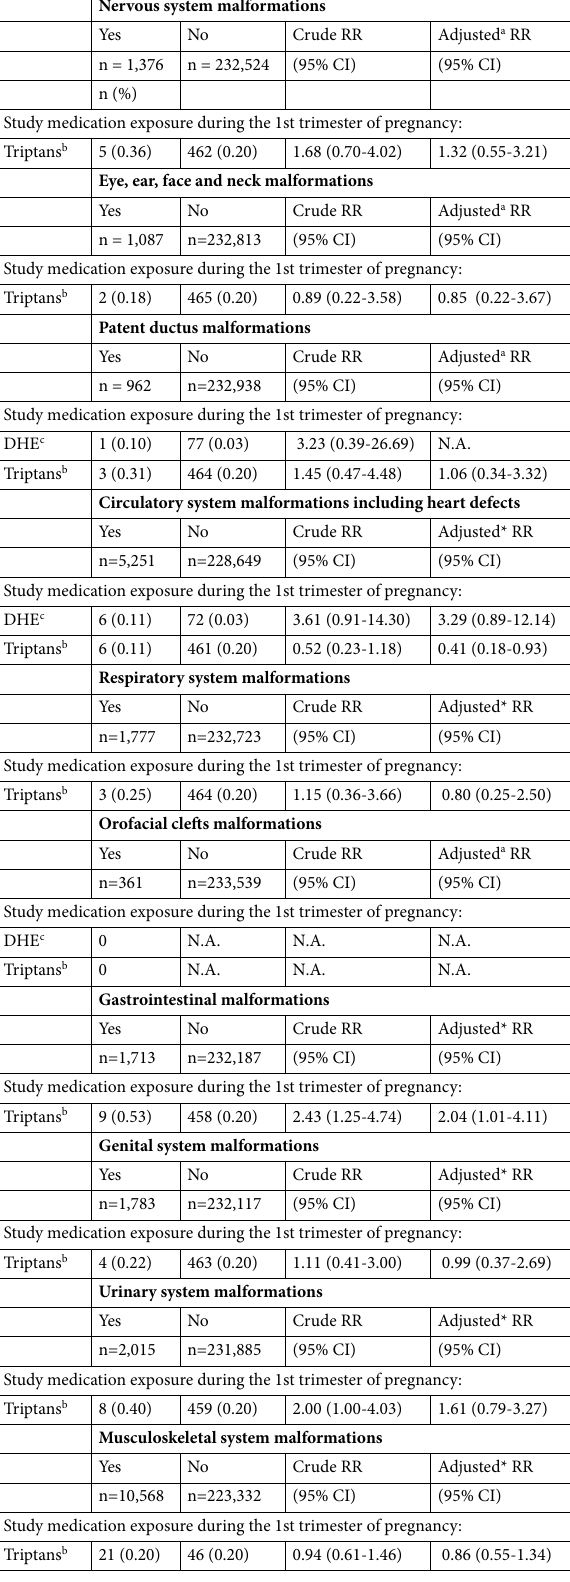
Table 5. Association between study medication exposures during the 1st trimester of pregnancy and the risk of organ-specific system malformations. a Adjusted for all variables included in the previous table. b Including almotriptan, eletriptan, naratriptan, rizatriptan, sumatriptan, and zolmitriptan; c Dihydroergotamine. Pregnant women can use more than 1 study medication during